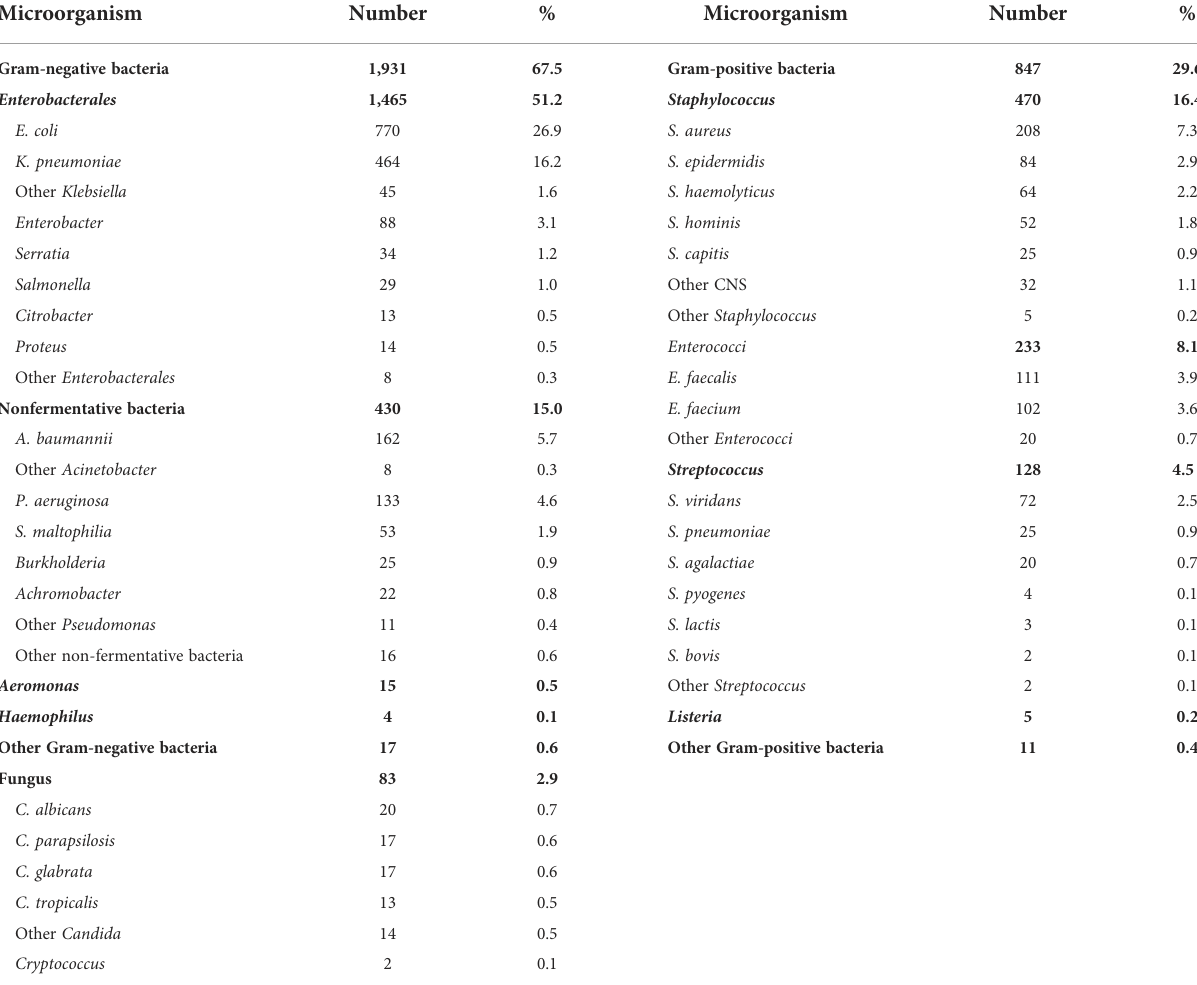
TABLE 3 Distribution of 2,861 strains of pathogens isolated from bloodstream